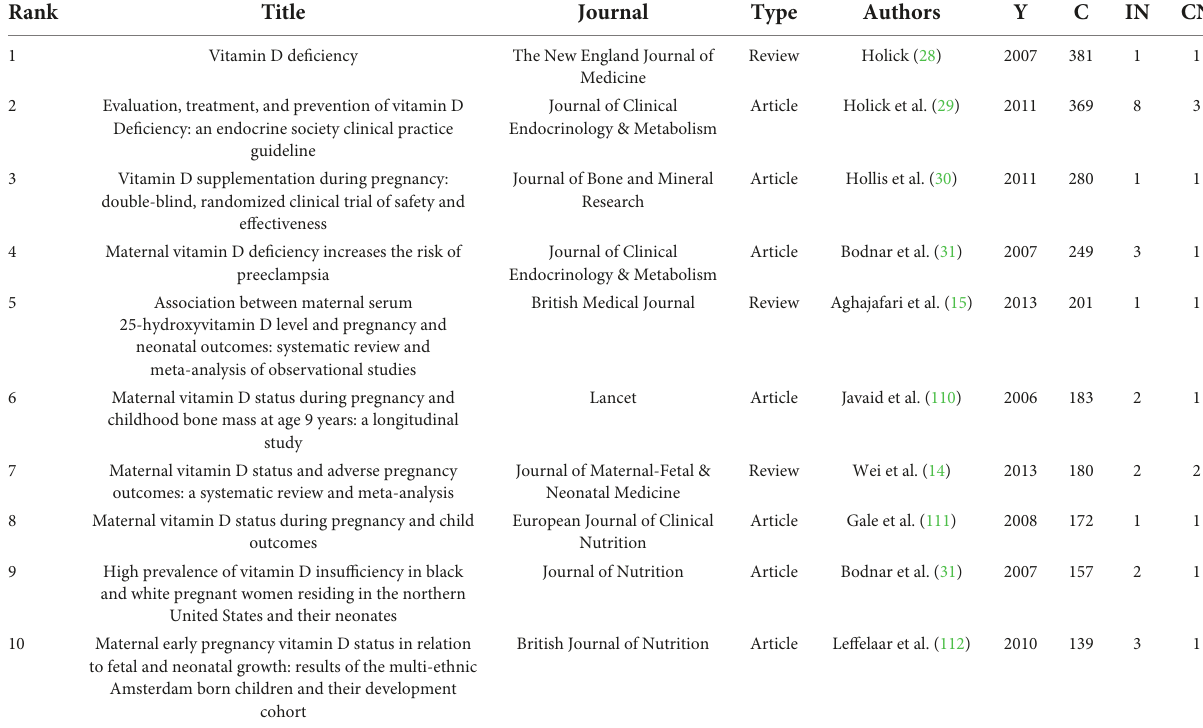
TABLE 7 Top 10 co-citation analysis of cited reference on vitamin D and reproductive health.